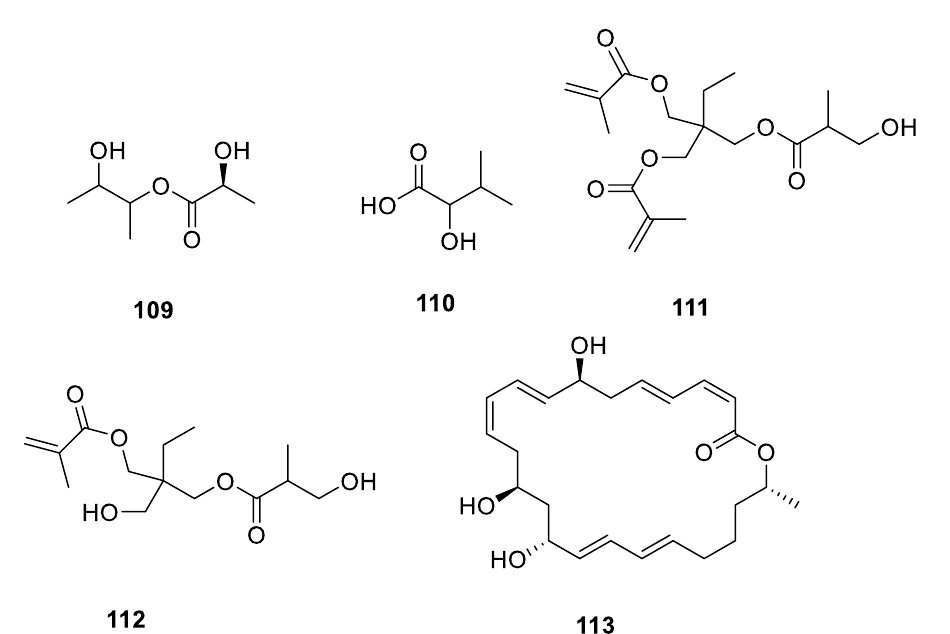
Figure 13. Chemical structures of compounds 109 − 113 from lichen-associated actinomycetota.